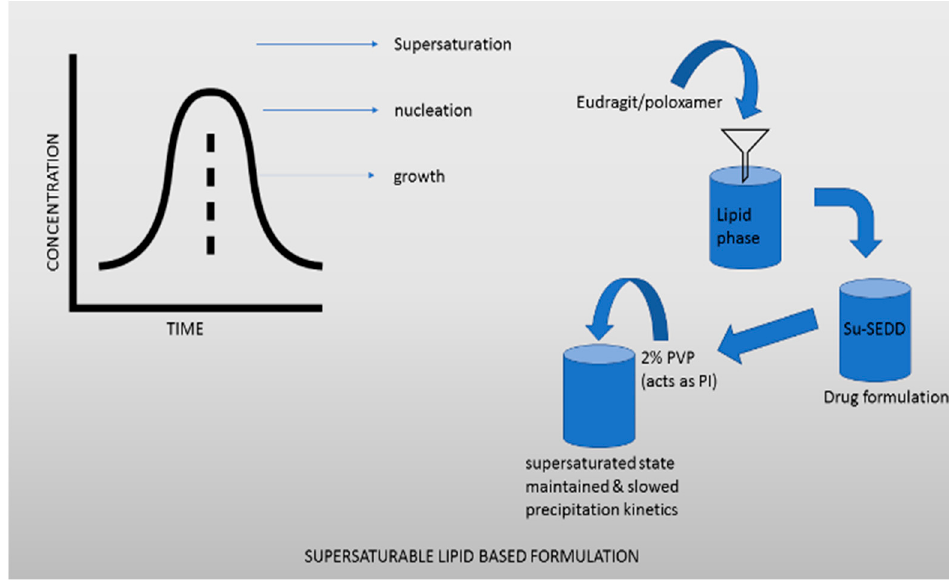
Figure 3. Supersaturable liquid base